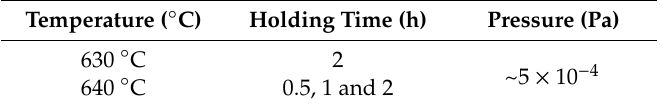
Figure 2. ( a ) Mixing procedure: Step 1—dispersion of pristine WC in isopropanol for 15 min in an ultrasonication bath; step 2—dispersion of Al powder in isopropanol at 5000 rpm for 5 min; and step 3—mixing of the two dispersions with simultaneous sonication at 11,000 rpm with the mixing vessel is in the ultrasonication bath; ( b ) SEM/BSE image of the dry Al-1 vol.% WC mixture. Table 1. Sintering conditions of non-reinforced Al and of Al-1 WC vol.%